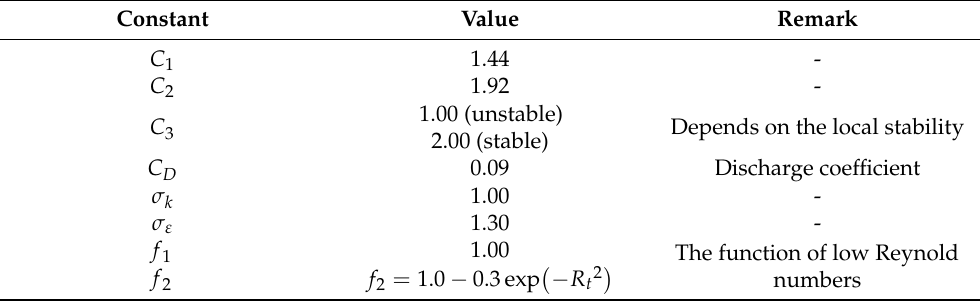
Table 7. Constants in the standard k- ε turbulence model [52].